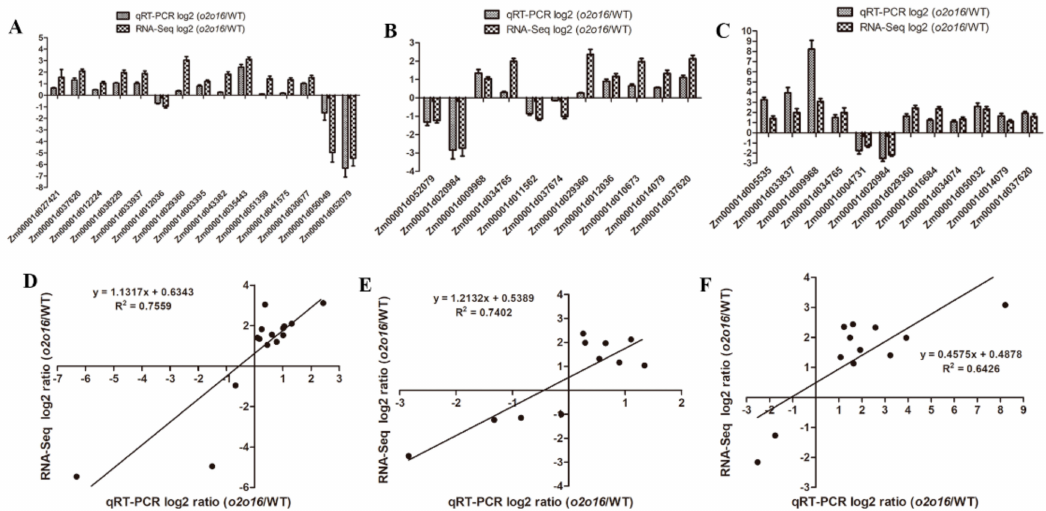
Figure 8. Validation of expression di ff erences identified by RNA-Seq through qRT-PCR of DEGs. ( A ) Histogram of the 15 DEGs in 18 DAP wild-type and o2o2o16o16 endosperm. ( B ) Histogram of the 11 DEGs in 28 DAP wild-type and o2o2o16o16 endosperm. ( C ) Histogram of the 12 DEGs in 38 DAP wild-type and o2o2o16o16 endosperm. ( D ) Scatter plots of the 15 DEGs in 18 DAP wild-type and o2o2o16o16 endosperm (R 2 = 0.7559). ( E ) Scatter plots of the 11 DEGs in 28 DAP wild-type and o2o2o16o16 endosperm (R 2 = 0.7402). ( F ) Scatter plots of the 12 DEGs in 38 DAP wild-type and o2o2o16o16 endosperm (R 2 =